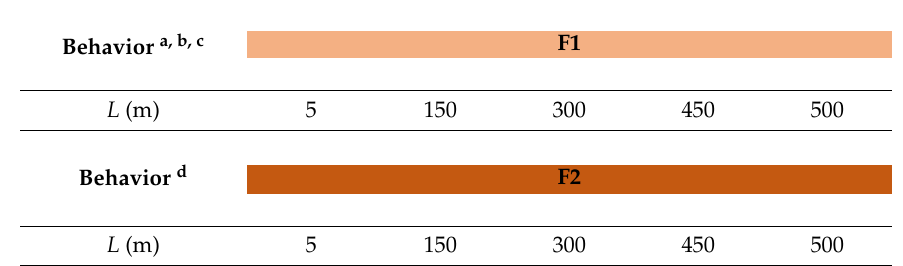
Table 4. Summary of the leaching-tubing-like systems behavior with increasing L from 5 to 500 m.